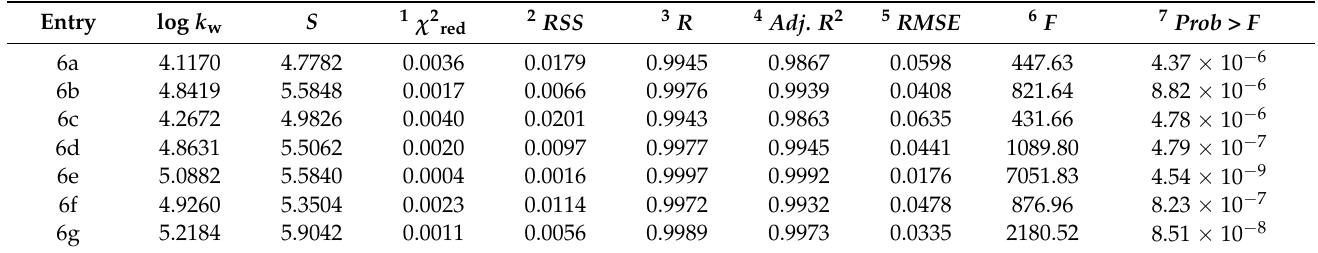
Table 2. Extrapolated log k w parameters and S (slope) data (RP-HPLC) of the 6a – g set together with the calculated values of statistical descriptors ( χ 2 red , RSS , R , Adj. R 2 , RMSE , F , and Prob > F ), which defined the linearity between log k and ϕ M for a particular molecule. The indication of a significance level of the F -ratio ( Prob > F parameter): extremely significant in all cases.